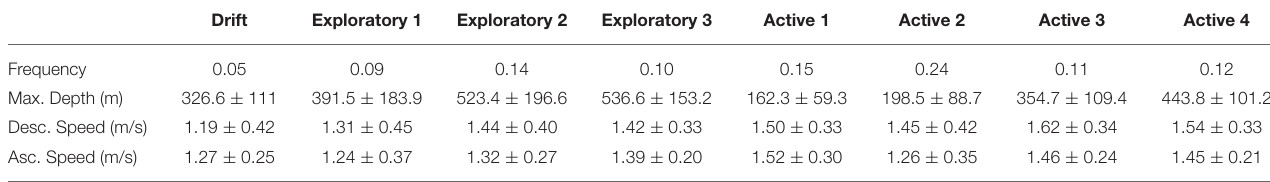
TABLE 1 | Characteristics of dive clusters. All differences between median of these groups are statistically significant ( p < 0.001, Kruskal Wallis